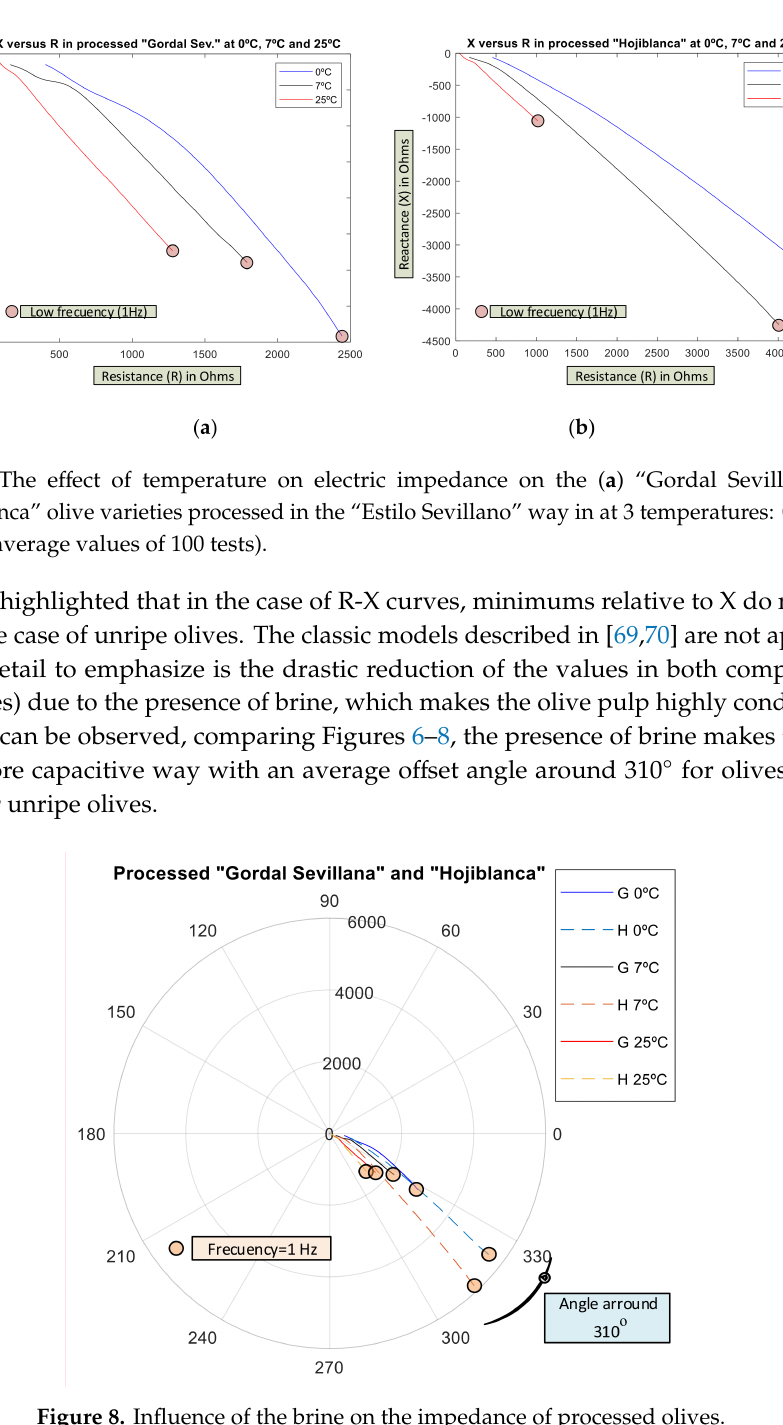
Figure 8. Influence of the brine on the impedance of processed